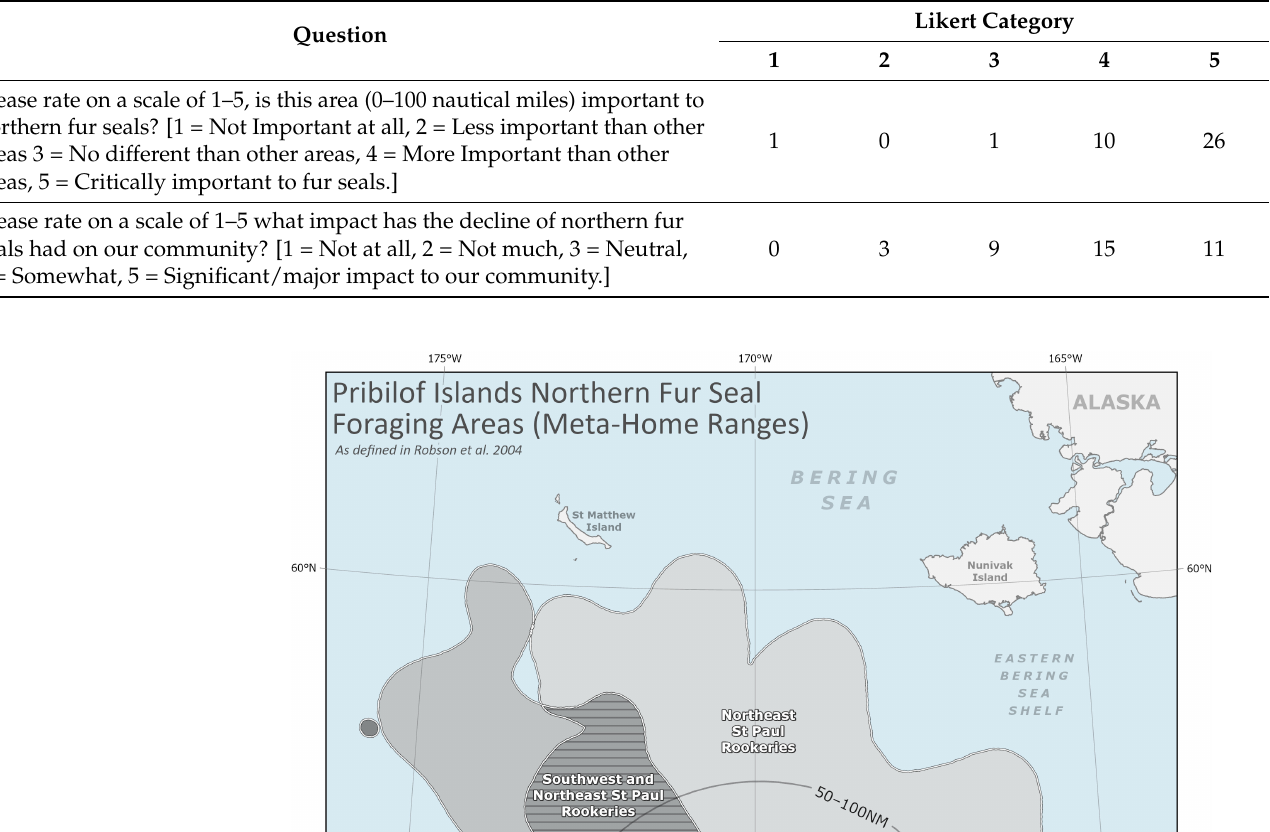
Table A3. Likert questions and response frequency from community surveys.